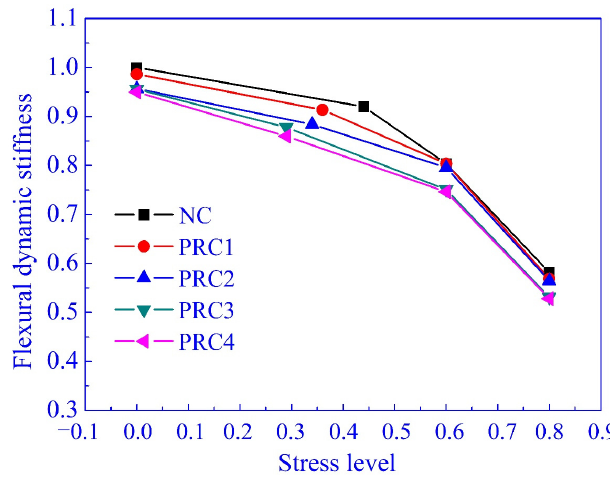
Figure 10. The effect of stress level on the natural frequency.